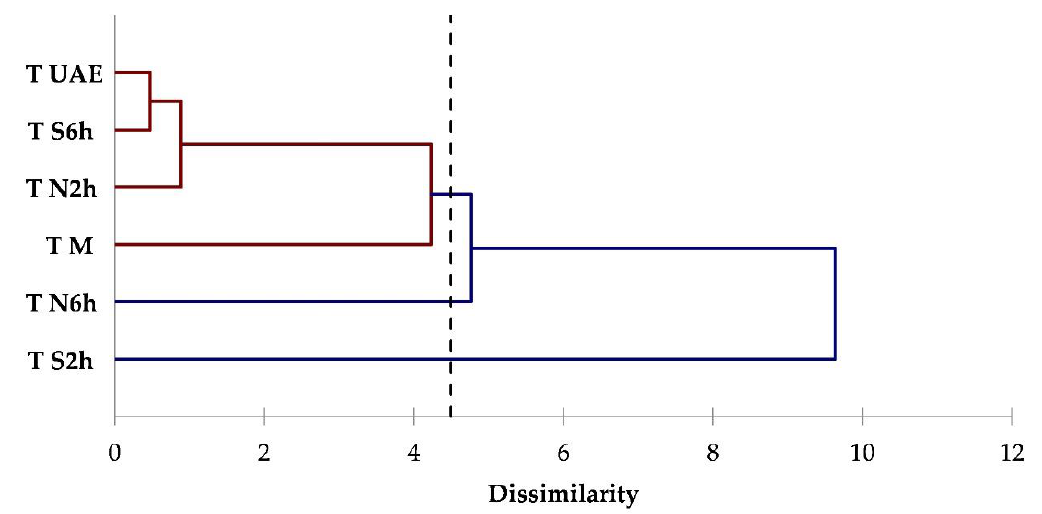
Figure 4. Dendrogram obtained from the cluster analysis based on terpenes classes data for thyme extracts.